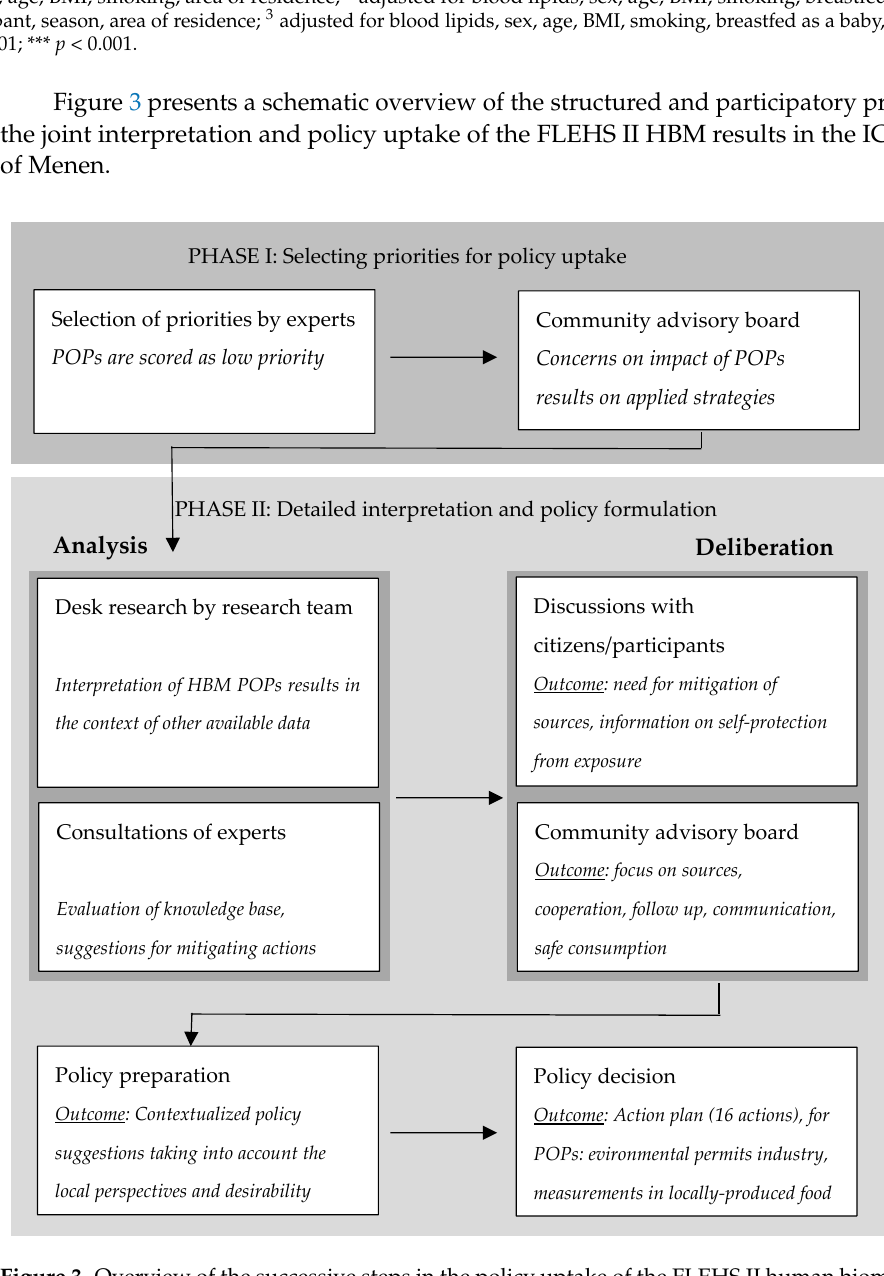
Figure 3. Overview of the successive steps in the policy uptake of the FLEHS II human biomonitoring results in the region of Menen. POPs: persistent organic pollutants.